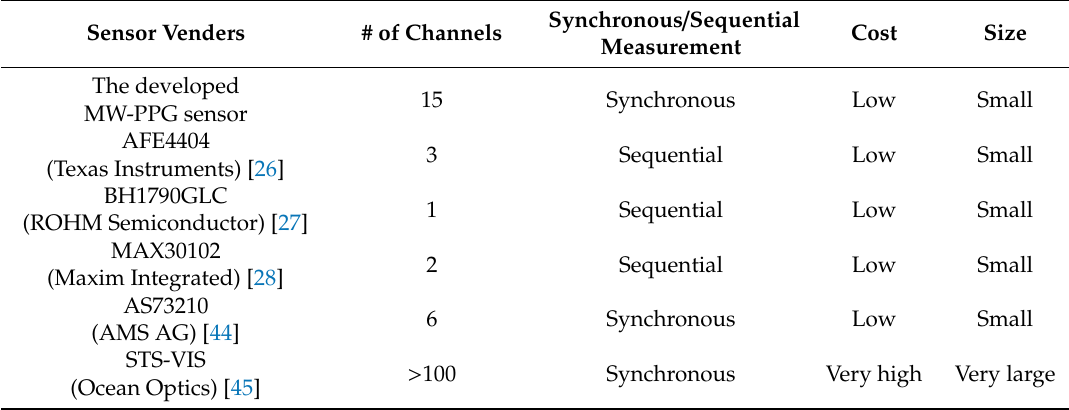
Table 1. Comparison of the proposed approach against other available solutions on the market if adapted for MW-PPG sensing. 275